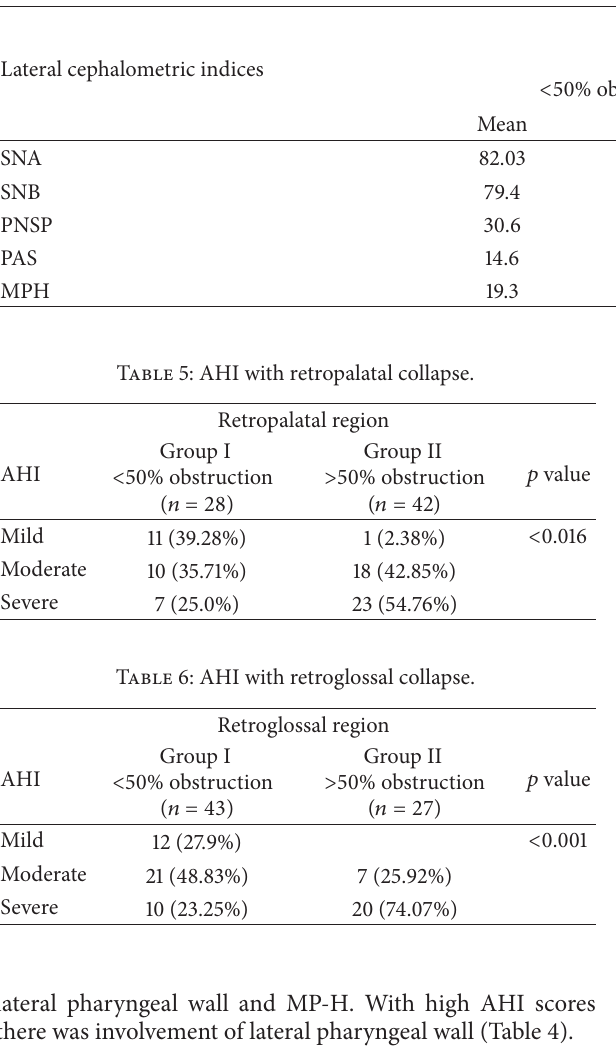
Table 4: Association of lateral pharyngeal wall on flexible nasopharyngolaryngoscopy with lateral cephalometric variables.